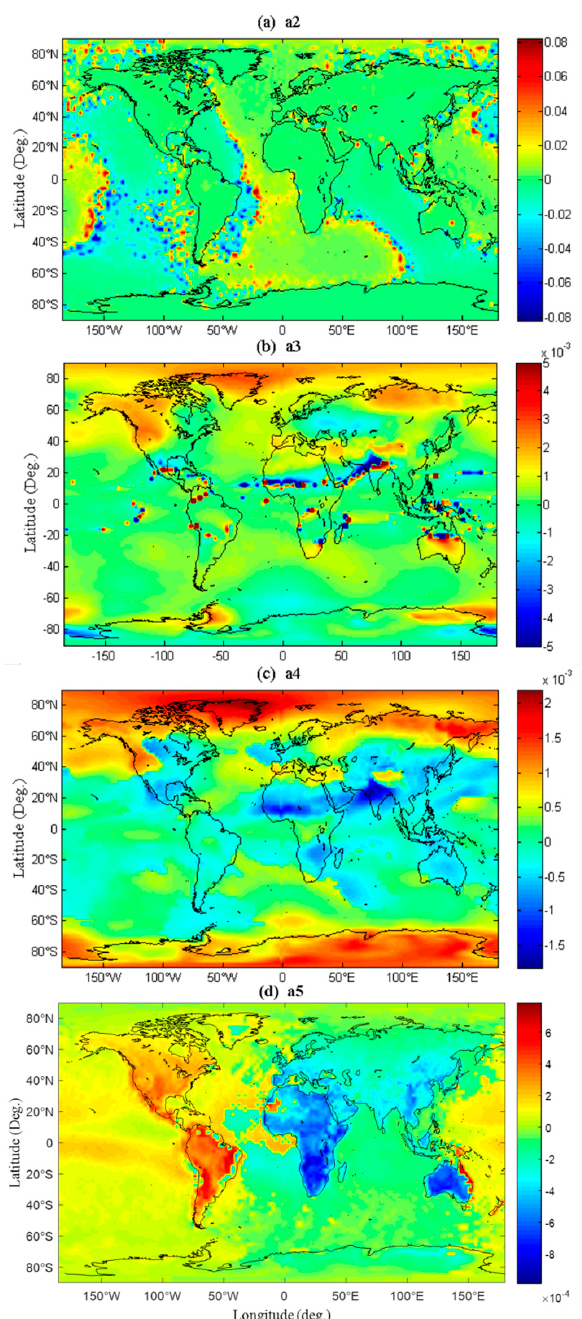
Figure 6. Coefficients distribution of the established global conversion factors globally estimated using the least squares method, where ( a ), ( b ), ( c ) and ( d ) represent the distribution of coefficients a2, a3, a4, and a5, respectively.